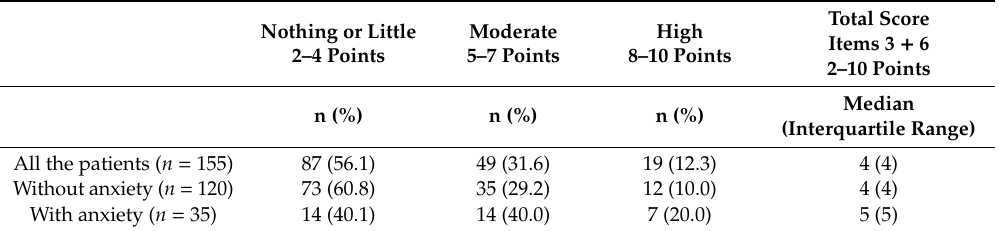
Table 3. Need for information according to APAIS in all the patients and those cataloged as with or without